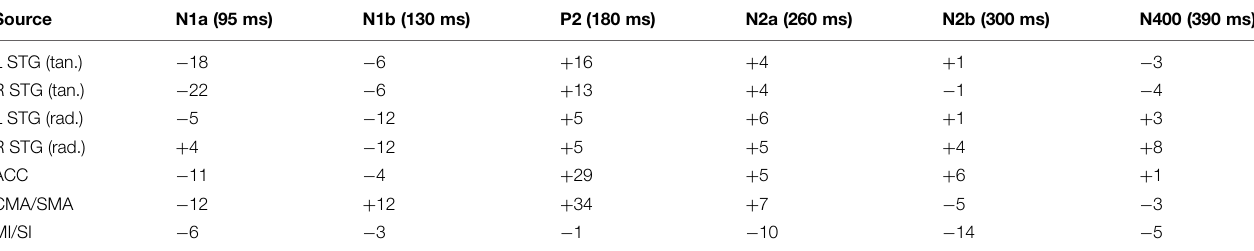
TABLE 2 | Source current strengths (nA) for the optimum source model.